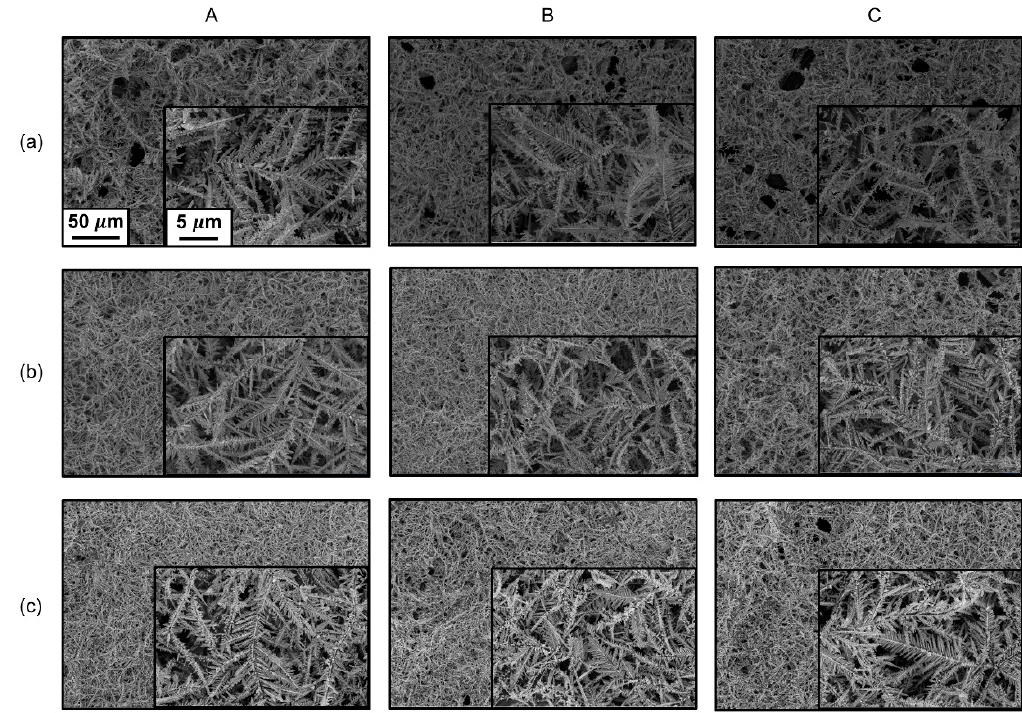
Figure 4. FE-SEM images of the fabricated 25.5 cm 2 Ag GDE (Figure 3) according to the position on the electrode. Ag deposition was performed with different deposition current densities: ( a ) 0.63 mA/cm 2 , ( b ) 0.83 mA/cm 2 and ( c ) 1.03 mA/cm 2 .